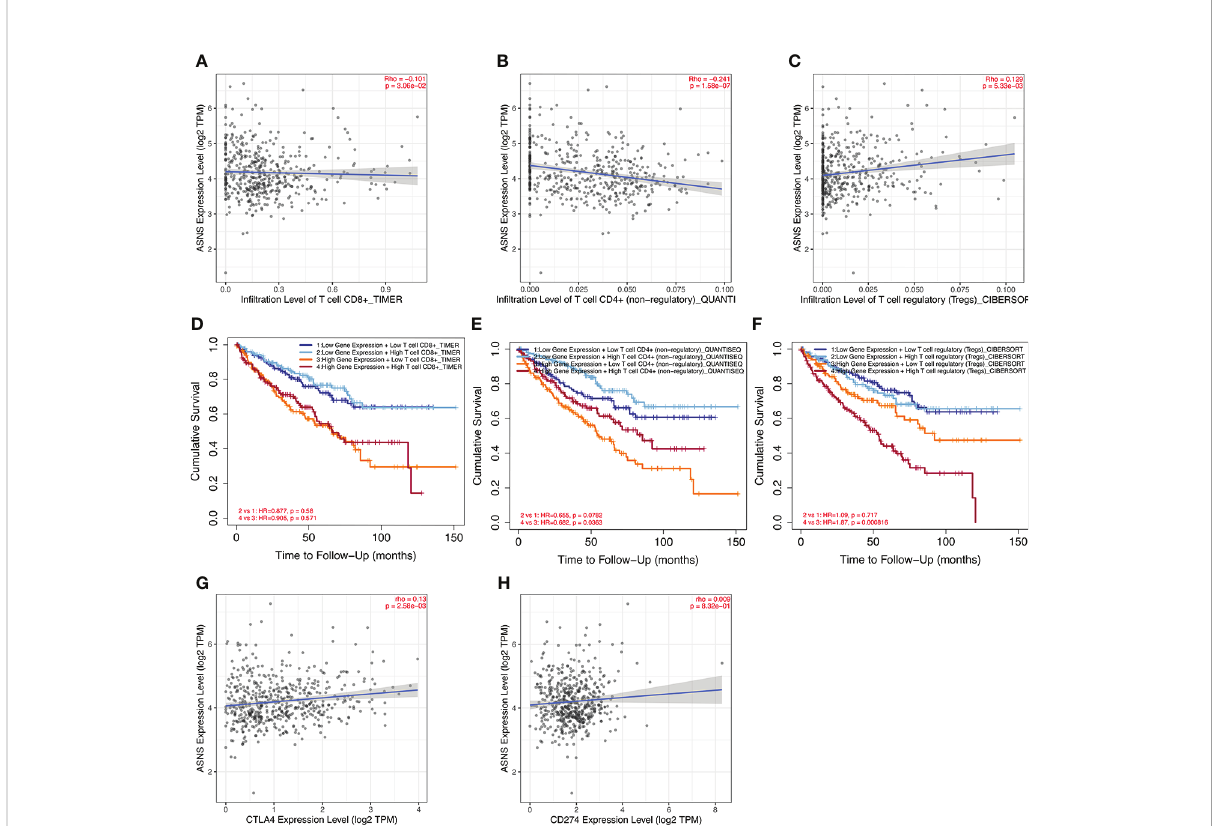
FIGURE 5 Immune in fi ltration analysis of ASNS in ccRCC. (A – C) Correlation between ASNS expression and immune cell in fi ltration in ccRCC. (D – F) Correlation between immune cell in fi ltration and prognosis. (G, H) Correlation between ASNS and expression level of immune checkpoint